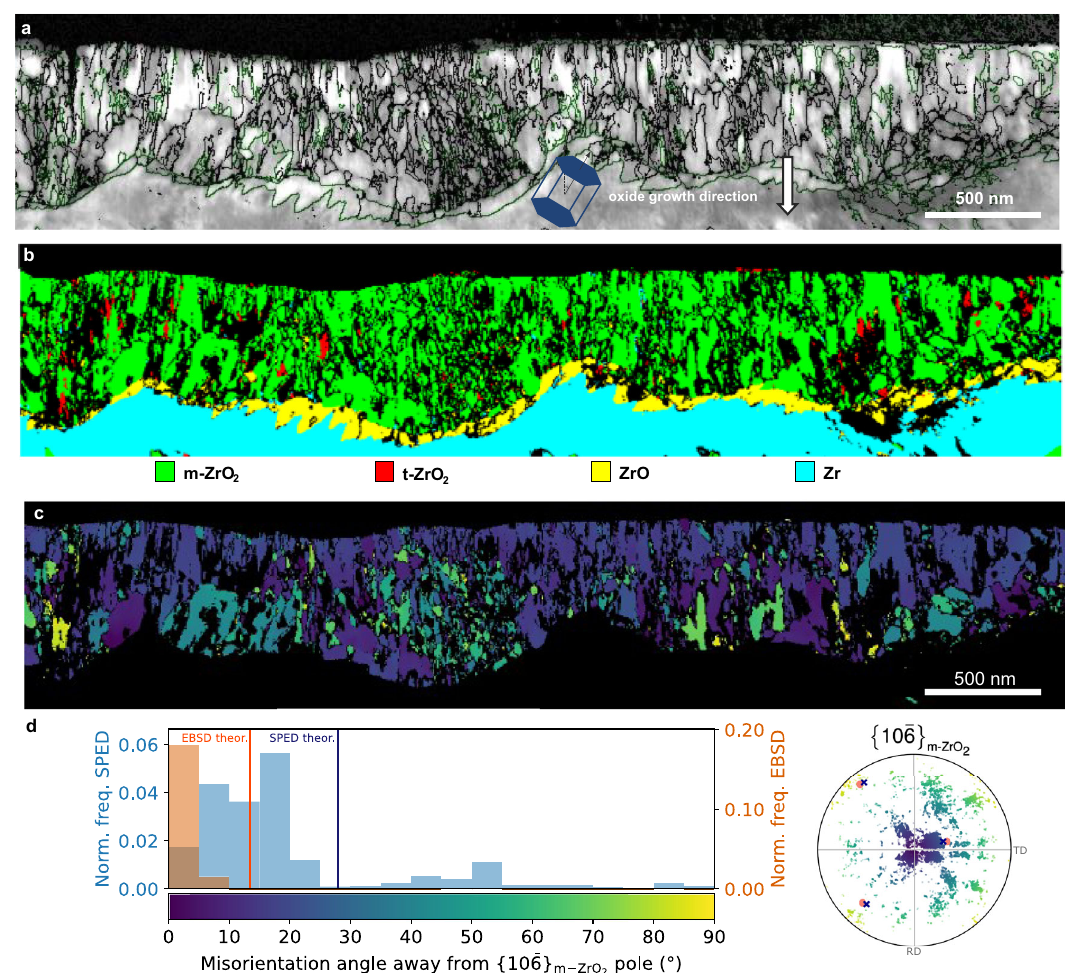
Fig. 4 | Oxide microstructure in region 1 measured using scanning electron precession diffraction (SPED) in the TEM. a Correlation index map with overlaid monoclinicoxidegrainboundariesshowninblack(interphaseboundariesshownin green). The orientation of the Zr hcp unit cell is shown and the oxide growth direction is marked with an arrow. b Phase map with phase reliability values less than 10 shown as non-indexed points (in black) and indexed points coloured according to legend below ( b ). c Monoclinic ZrO 2 orientation map coloured